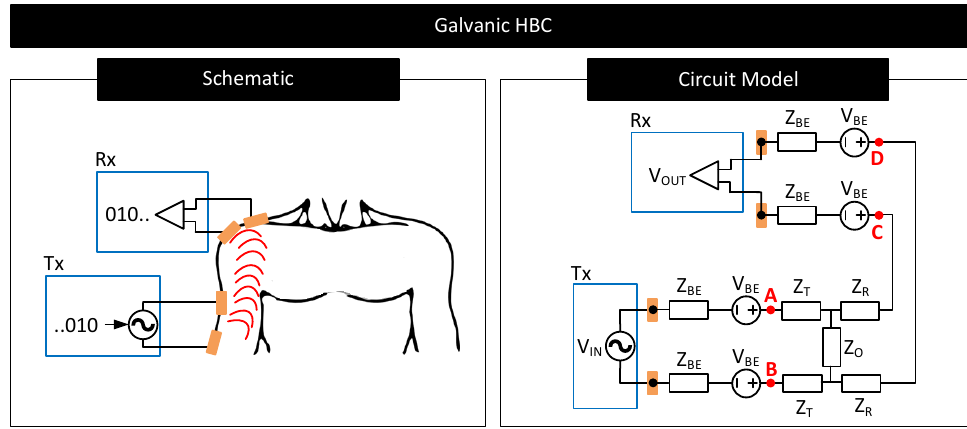
Figure 19. Simplified schematic and circuit model of galvanic HBC. Circuit elements V BE and Z BE model the contact potential and impedance of the body–electrode interface. Circuit elements Z T , Z O and Z R are the Z-port representation of the impedances of the conductive core of the body